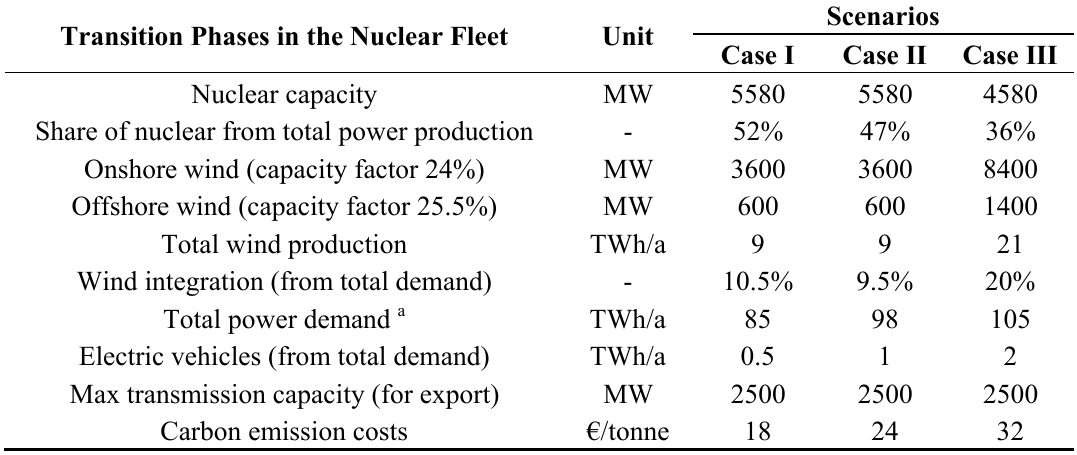
Table 3. Assumptions and projections for Finnish energy system in the decade of 2020s. Transition Phases in the Nuclear